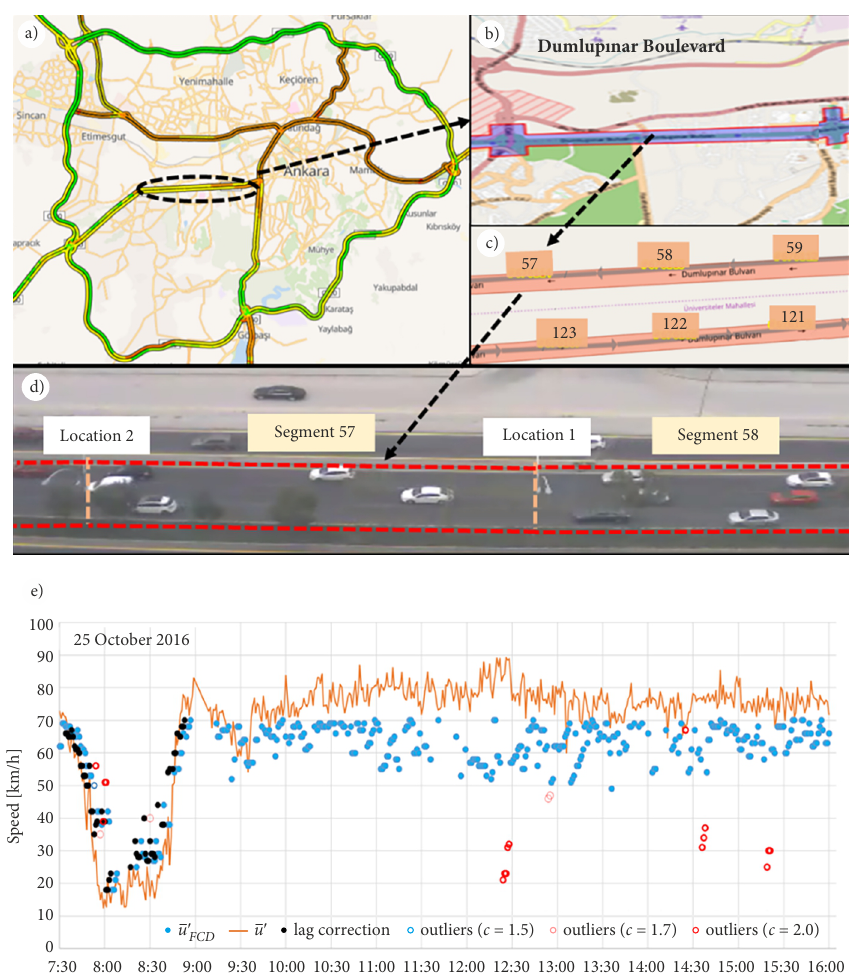
Figure 1. The border of the Ankara city and location of the Dumlupınar Boulevard (a, b); FCD segmentations and study segment on Dumlupınar Boulevard in Ankara (Turkey) (c, d); speed profiles of the commercial FCD and GT data at the study segment as well as the outliers in commercial FCD